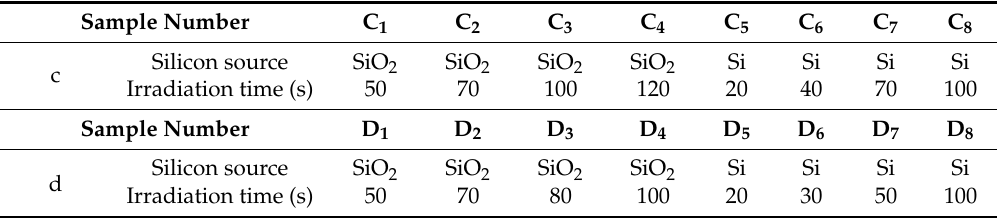
Table 2. Selected CMMC samples and reaction